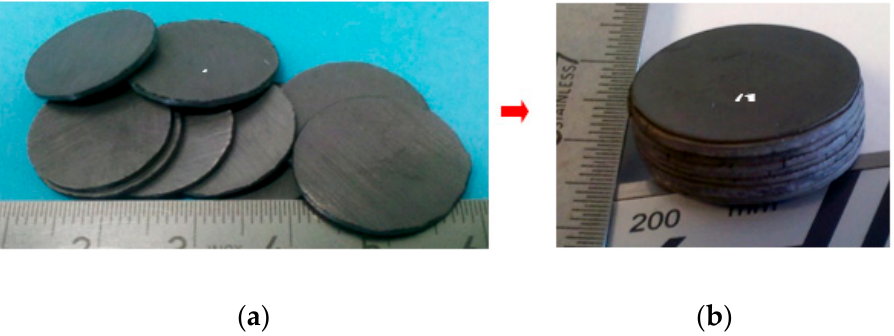
Figure 2. ( a ) As-processed and ( b ) hot-stacked Co349 pellet samples.